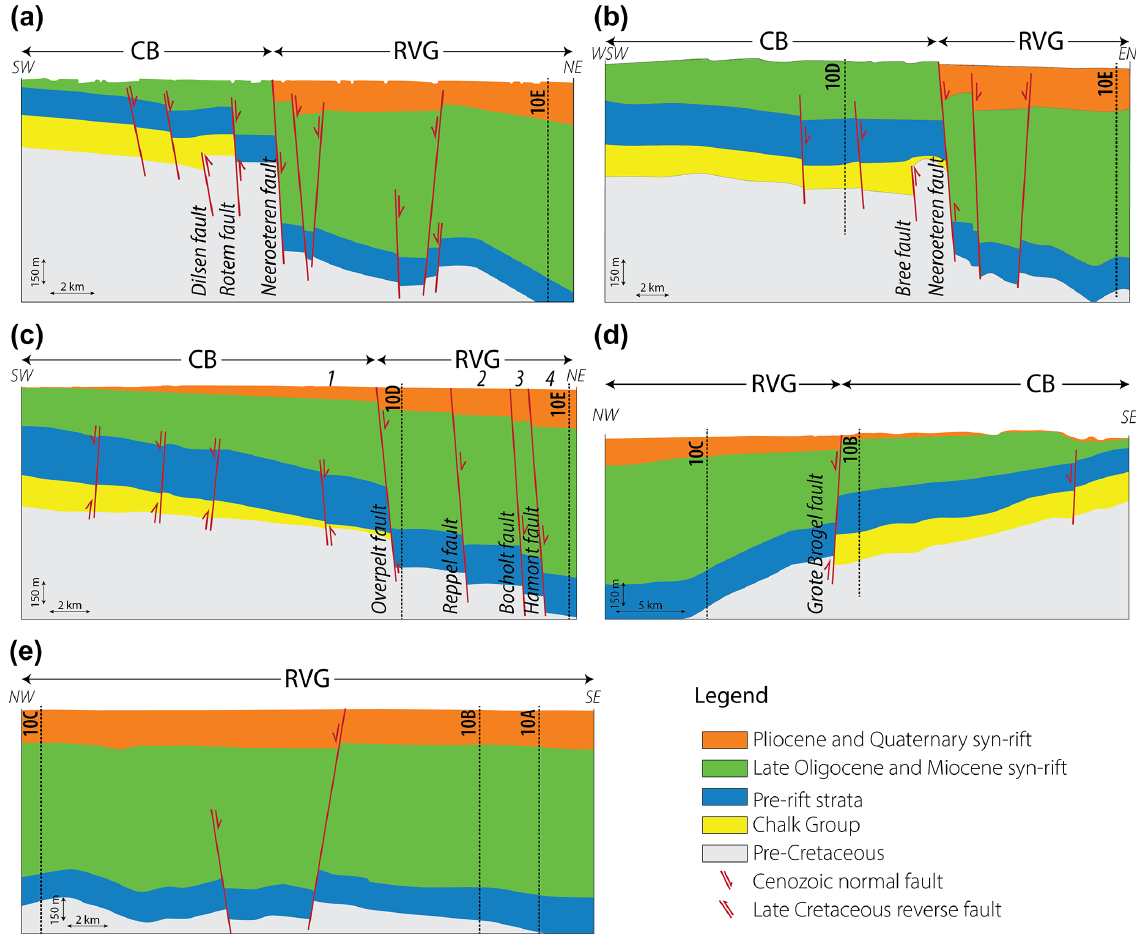
Figure 10. Sections constructed from the G3Dv3 model across (a, b, c) and along (d, e) the FFS. Panels (a) and (b) cross the southern domain of the FFS, while section C crosses the northern domain. Panel (d) runs from the footwall of the southern domain of the FFS (or in the CB) into the northern domain of the FFS. Panel (e) runs across the hanging wall of the FFS or in the RVG. The locations of these sections are indicated in Figs. 7 and 9: 1 – Lommel Plain; 2 – Reppel Plain; 3 – Kaulille Plain; 4 – Bocholt